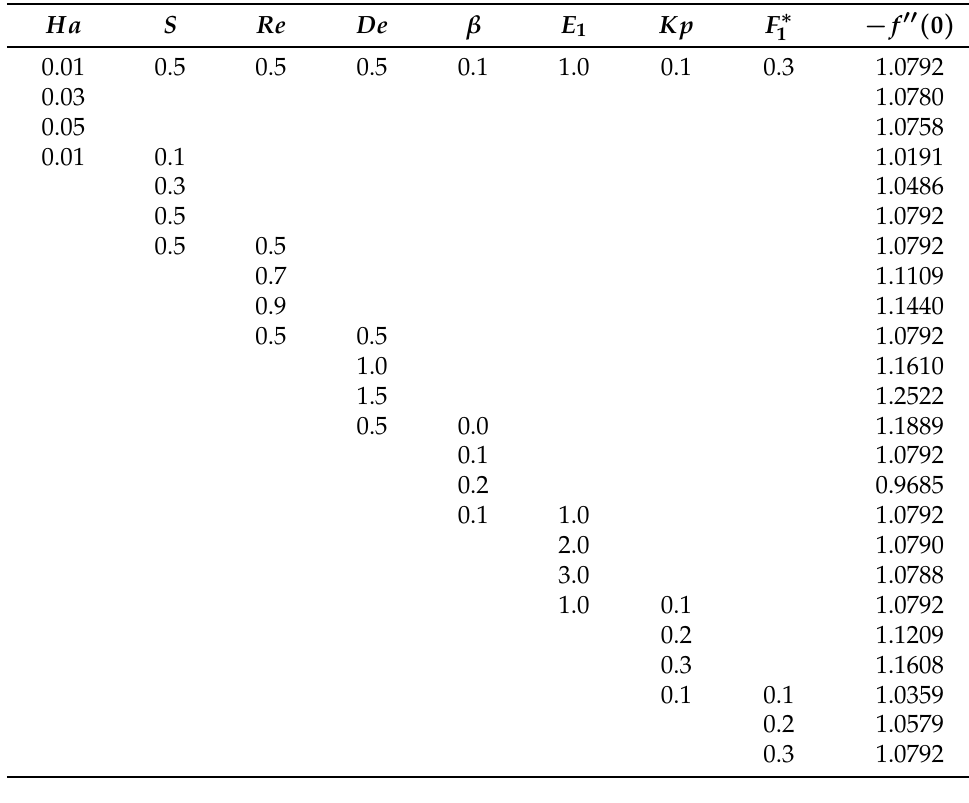
Table 2. Results for − f (cid:48)(cid:48) ( 0 ) .